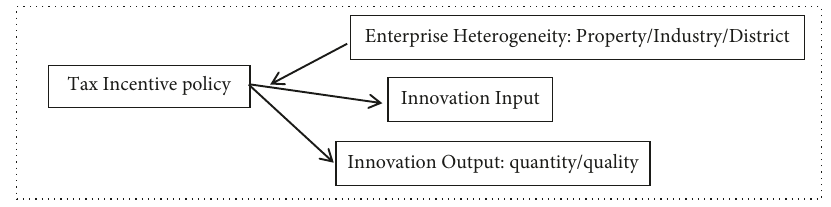
Figure 1: Research conceptual model. Table 1: Descriptive statistics of main variables.